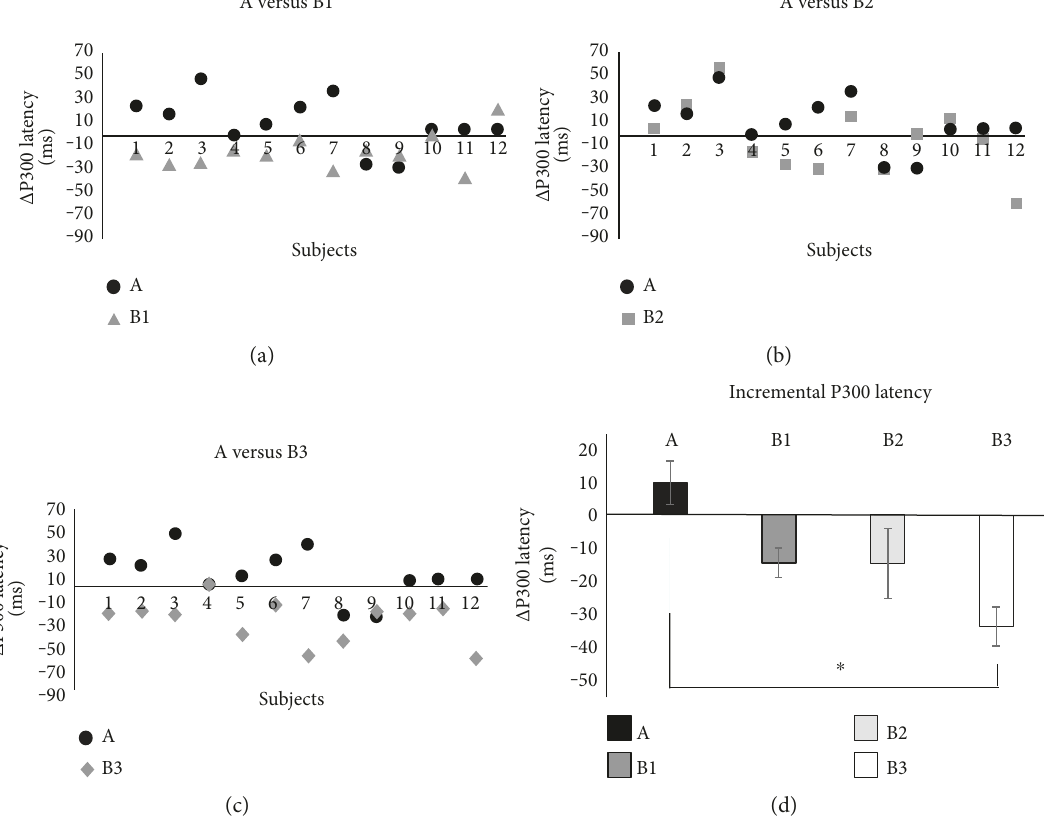
Figure 4: The P300 latency incremental values measured in each of the twelve subjects in association to breakfasts (a) B1, (b) B2, and (c) B3, respectively. For the sake of comparison, each of the three panels also displays P300 latency incremental values measured in association to glucose ingestion (black dots, glucose). (d) The means of the P300 latency incremental values for each test. Of note is that a negative value stands for a peak anticipation. ∗ p < 0 01